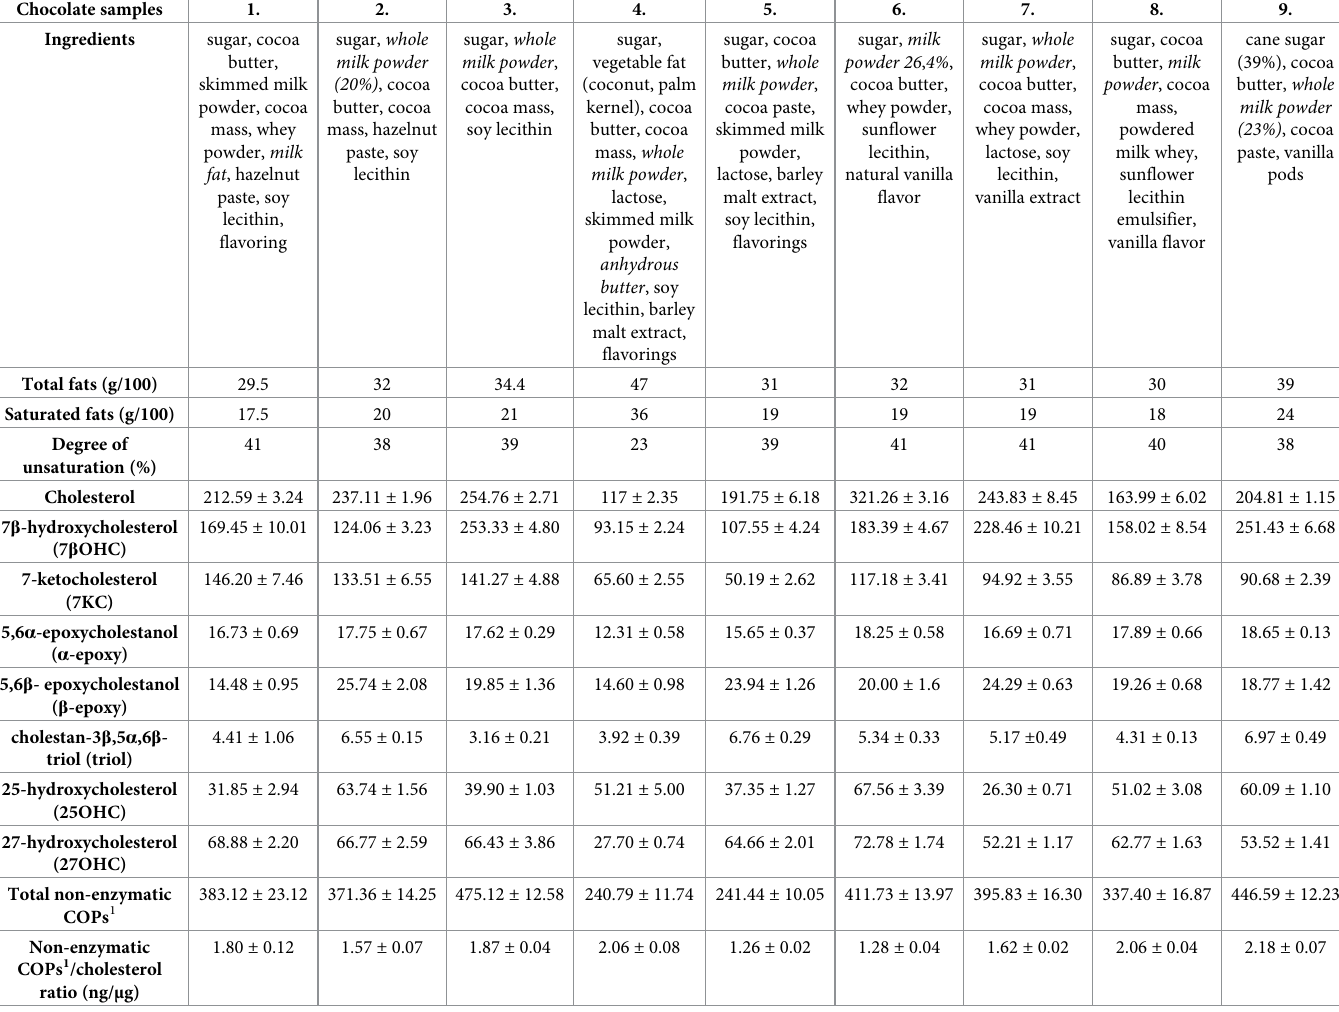
Table 3. Ingredients, fat composition as indicated by the manufacturer, cholesterol ( μ g/g), and COPs (ng/g) content of the commercial samples of milk chocolate included in the study. Chocolate